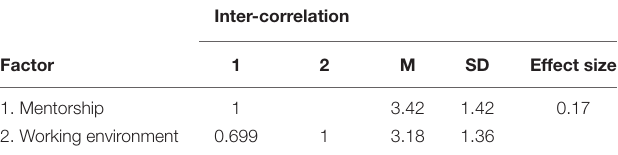
TABLE 5 | Inter-correlation of the two-factor institutional